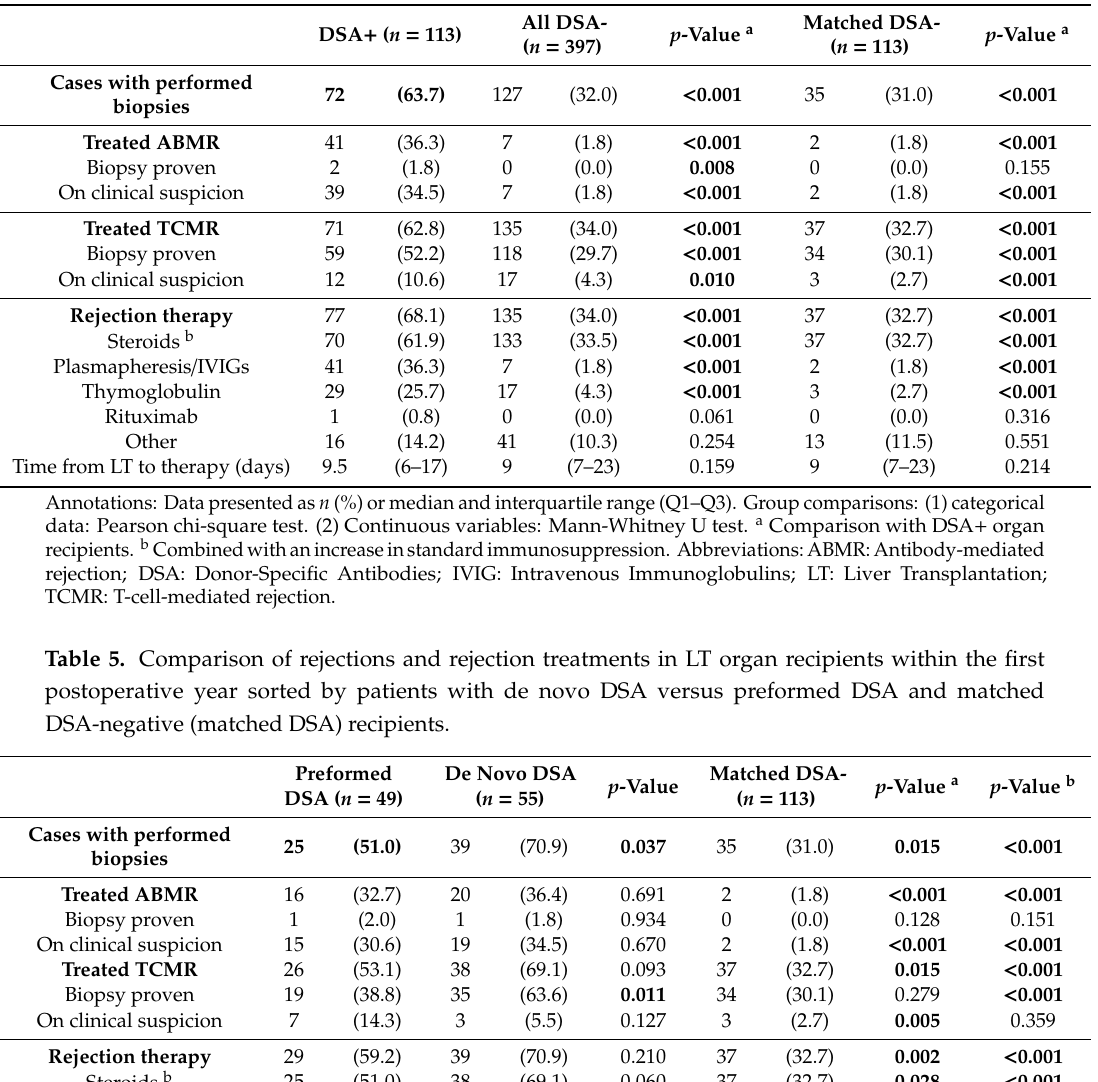
Table 4. Comparison of rejections and rejection treatments in LT organ recipients within the first postoperative year sorted by DSA-positive (DSA + ) versus DSA-negative (DSA-) and matched DSA-negative (matched DSA-) recipients.